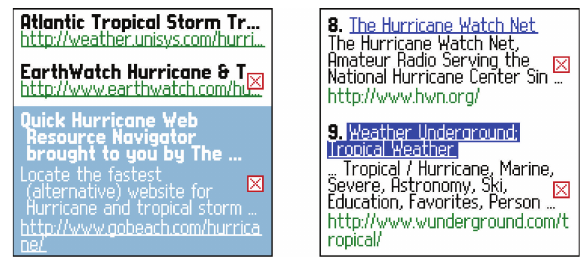
Figure 3: Selection markers in Mobile Findex UI (left) and Reference UI (right).